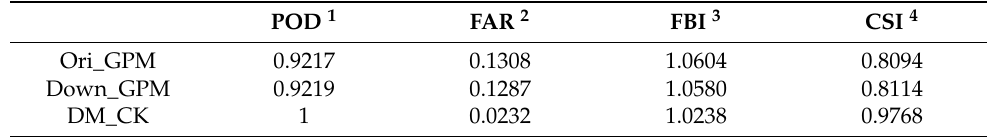
Table 6. Evaluation for categorical indices of BADP from the Ori_GPM, Down_GPM, and DM_CK in identifying the no-rain events over the study area from March 2016 to February